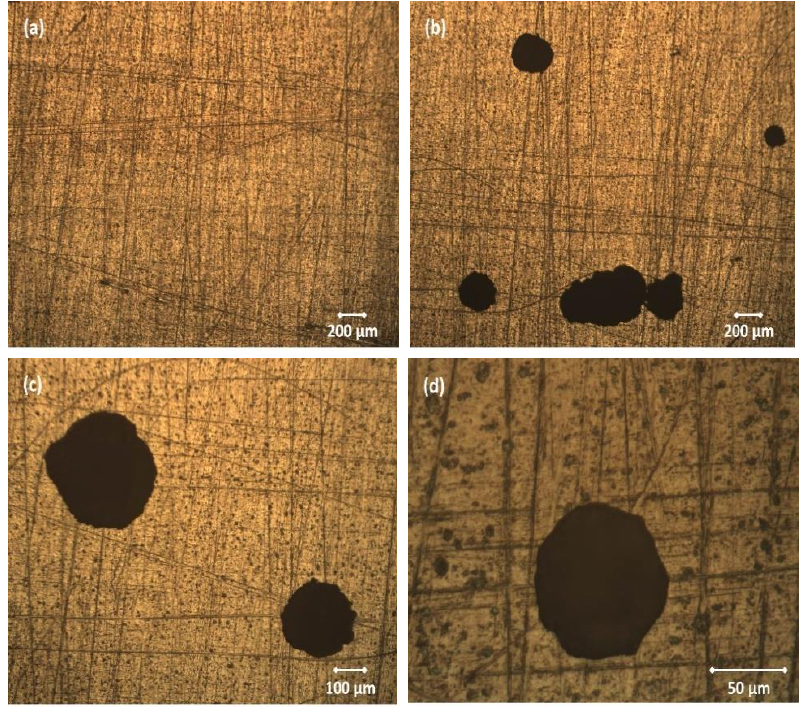
Figure 8. Optical microscopy micrographs for Zr2.5Nb alloy: ( a ) before corrosion (5 × ), ( b ) after